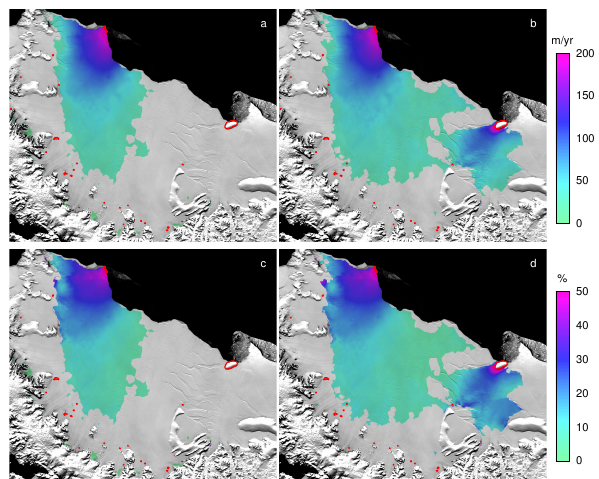
Fig. 6. (a) Change in velocity magnitude when backstress associ- ated with Bawden ice rise is removed; (b) change in velocity mag- nitude when backstress associated with both Bawden and Gipps ice rises is removed. Respective percent differences in (c) and (d) . Only areas with modeled velocity at least 20myr − 1 greater than observed are plotted. Red spots and contours same as in Fig. 5. All panels plotted over 2009 MOA